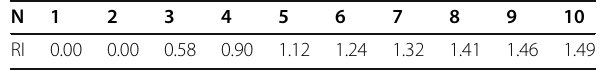
Table 3 Random inconsistency indices (Saaty,